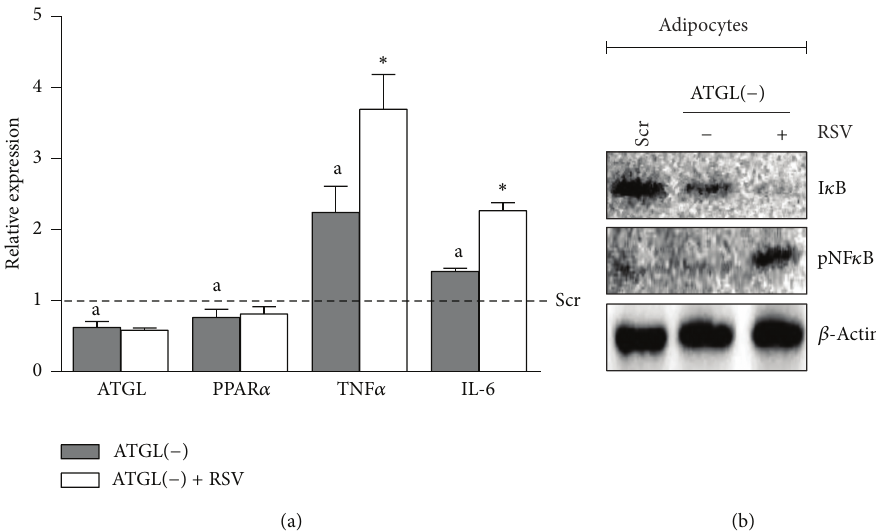
Figure 3: RSV does not revert inflammatory markers upregulation in ATGL lacking cells. (a) Differentiated 3T3-L1 adipocytes (8-days- old) were transfected with siRNA against ATGL [ATGL (−) ] or with a scramble siRNA (Scr) and treated with 100 𝜇 M RSV for 24 h. RT- qPCR analysis of relative ATGL, PPAR 𝛼 , TNF 𝛼 , and IL-6 mRNA levels. Values are given as means ± S.D. ( a ) 𝑃 < 0.05 versus Scr cells; (∗) 𝑃 < 0.01 versus RSV untreated cells. (b) Western blotting analysis of I 𝜅 B and phosphoactive form of NF 𝜅 B (pNF 𝜅 B) in total protein extracts of adipocytes. 𝛽 -Actin was used as loading control. Immunoblots are representative of at least 3 independent experiments.